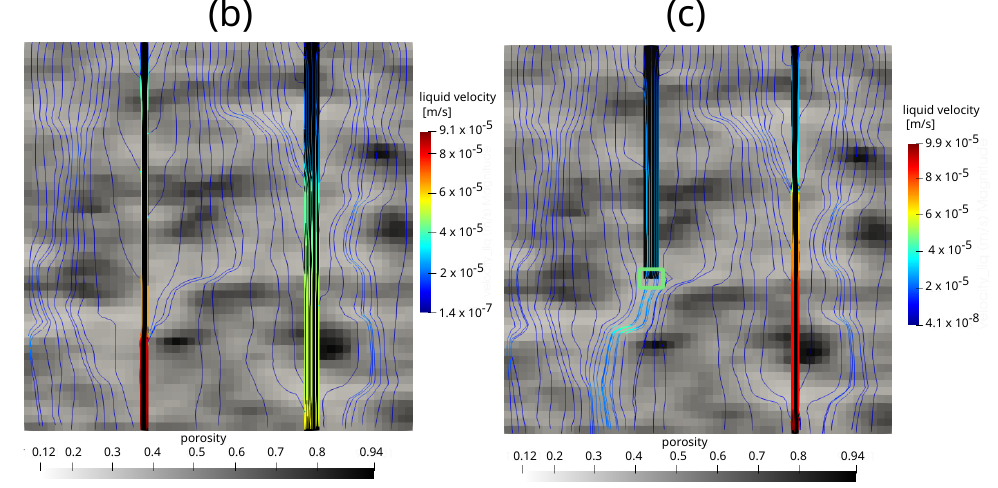
Figure 4. Water phase velocity streamlines of Forchheimer–Case 1 model for Scenarios (b) and (c).